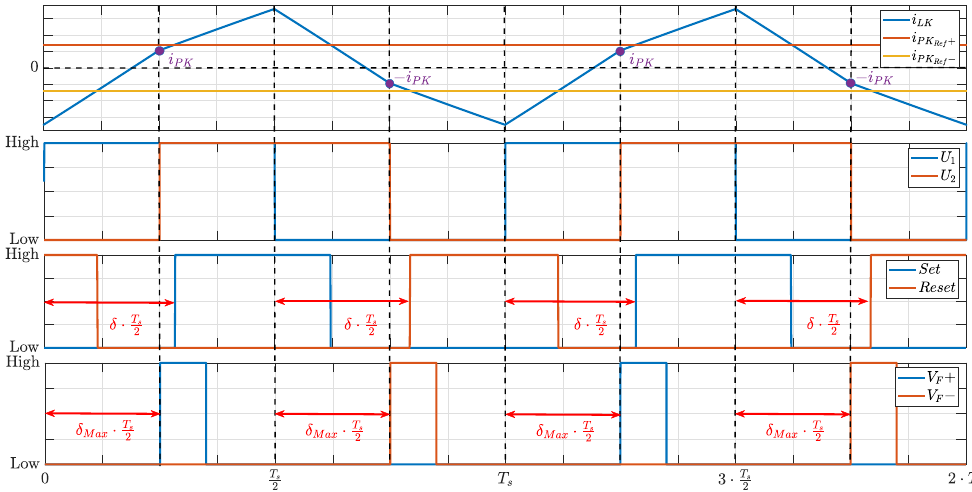
Figure 8. Changes in U 2 due to reaching of the maximum phase